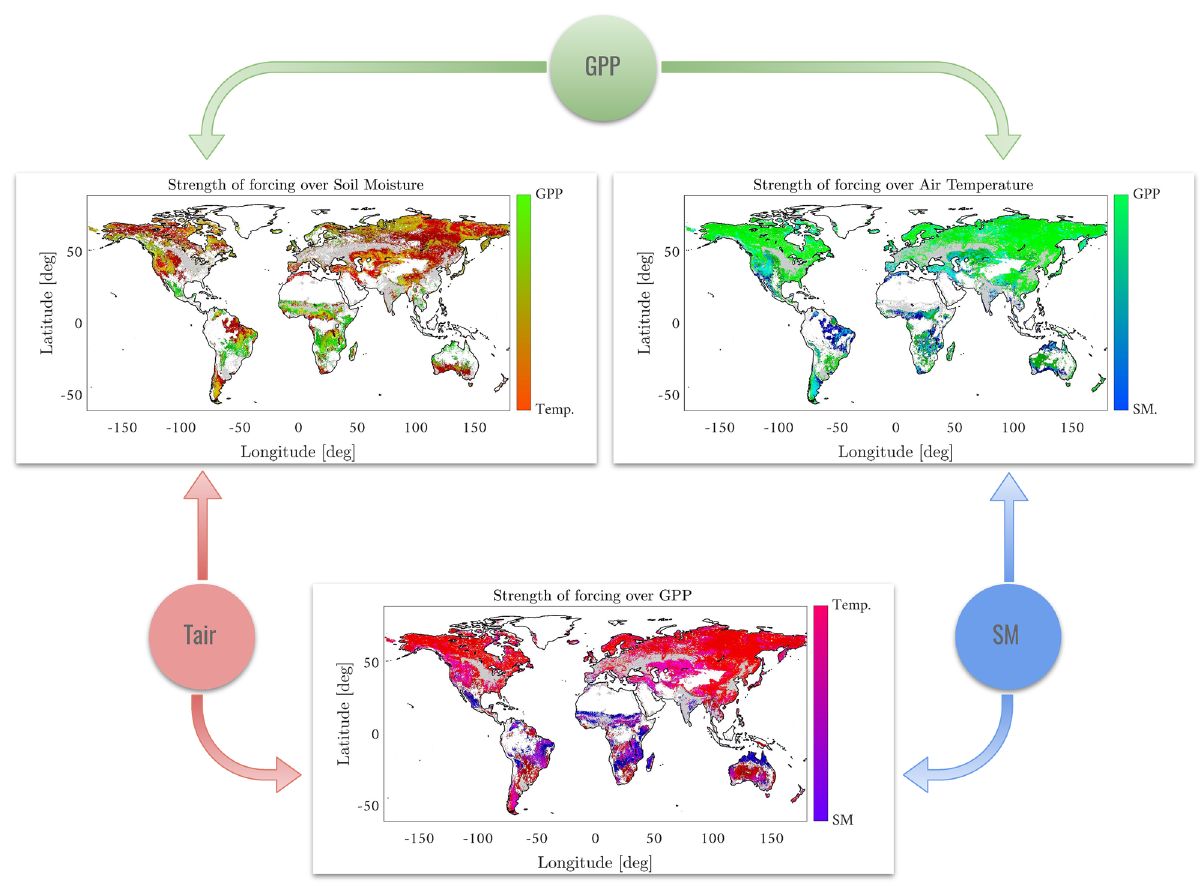
Figure 5. Application of the RCCM to derive causal relations between variables accounting for photosynthesis (GPP), temperature (Tair) and soil moisture (SM). Reasonable spatial causal patterns are observed for SM and Tair on GPP; GPP drives Tair mostly in cold ecosystems (probably due to changes in land surface albedo such as snow/ice to vegetation changes); SM is mostly controlled by Tair, which partially drives evaporation in water- limited regions; and GPP dominates SM. The grey areas in the images correspond with crop land areas that have been deliberately masked to avoid confounding effects due to human intervention specially on soil moisture. The figure was generated using Matlab version R2018a (https:// es. mathw orks. com) and Powerpoint version 2016 (https:// micro soft. com).